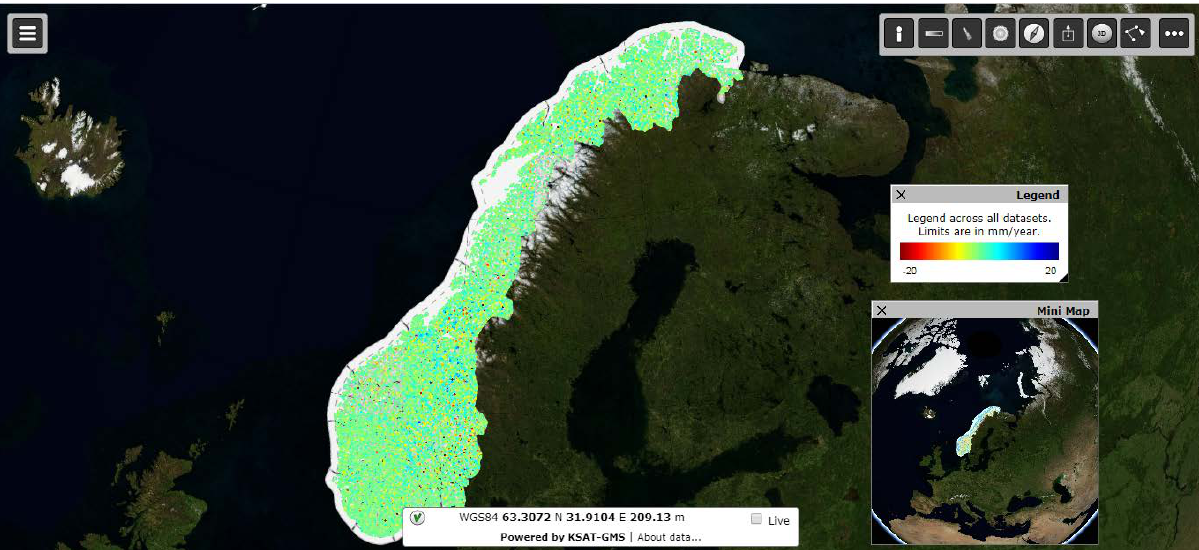
Figure 1. Example of wide area PSI monitoring: geoportal of the Norway Ground Motion Service - https://insar.ngu.no.